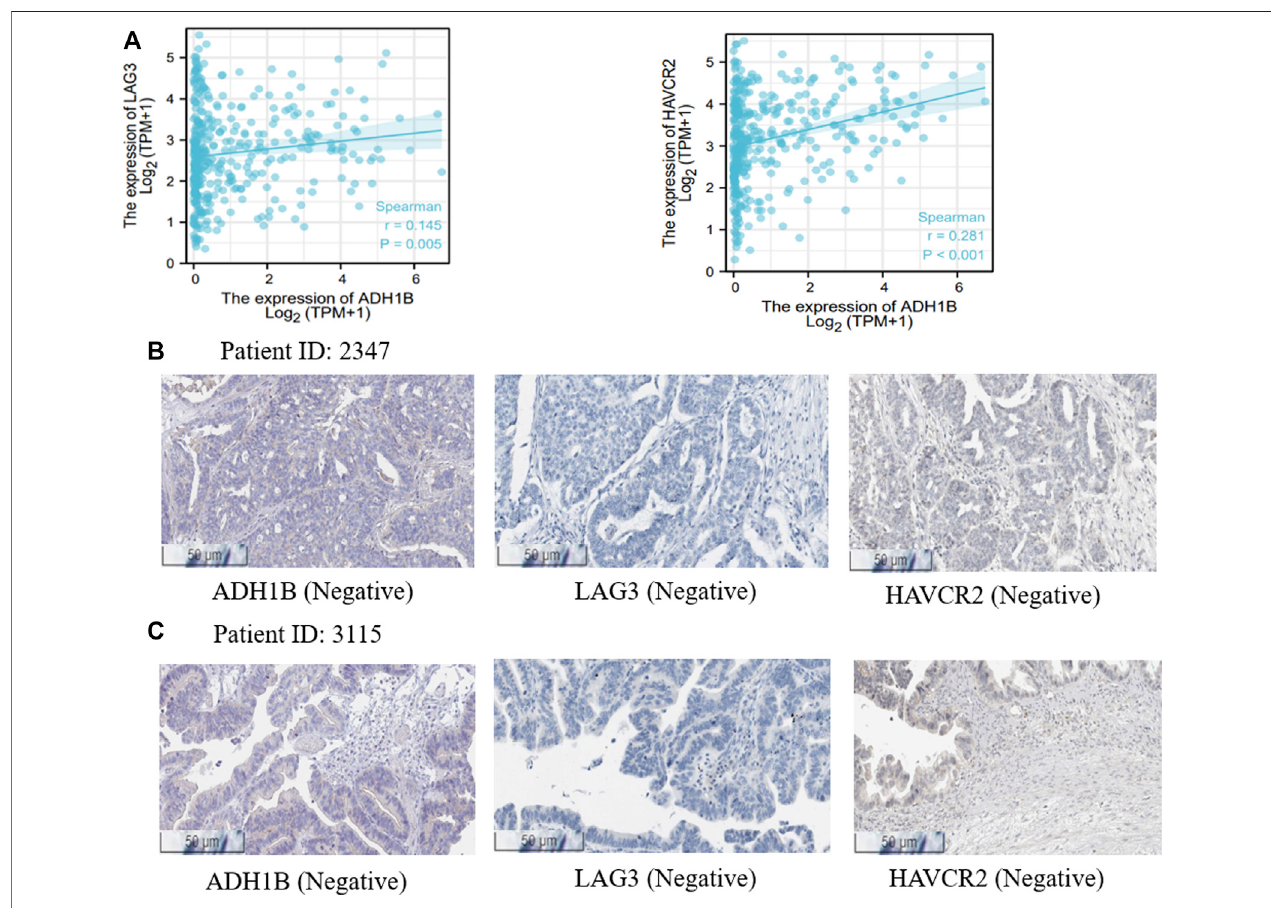
FIGURE 6 | Treatment correlation analysis of ADH1B. (A) The associations between ADH1B with LAG3 and HAVCR2. (B,C) the Human Protein Atlas portal validated the downregulated ADH1B, LAG3, and HAVCR2 in OV tissues.